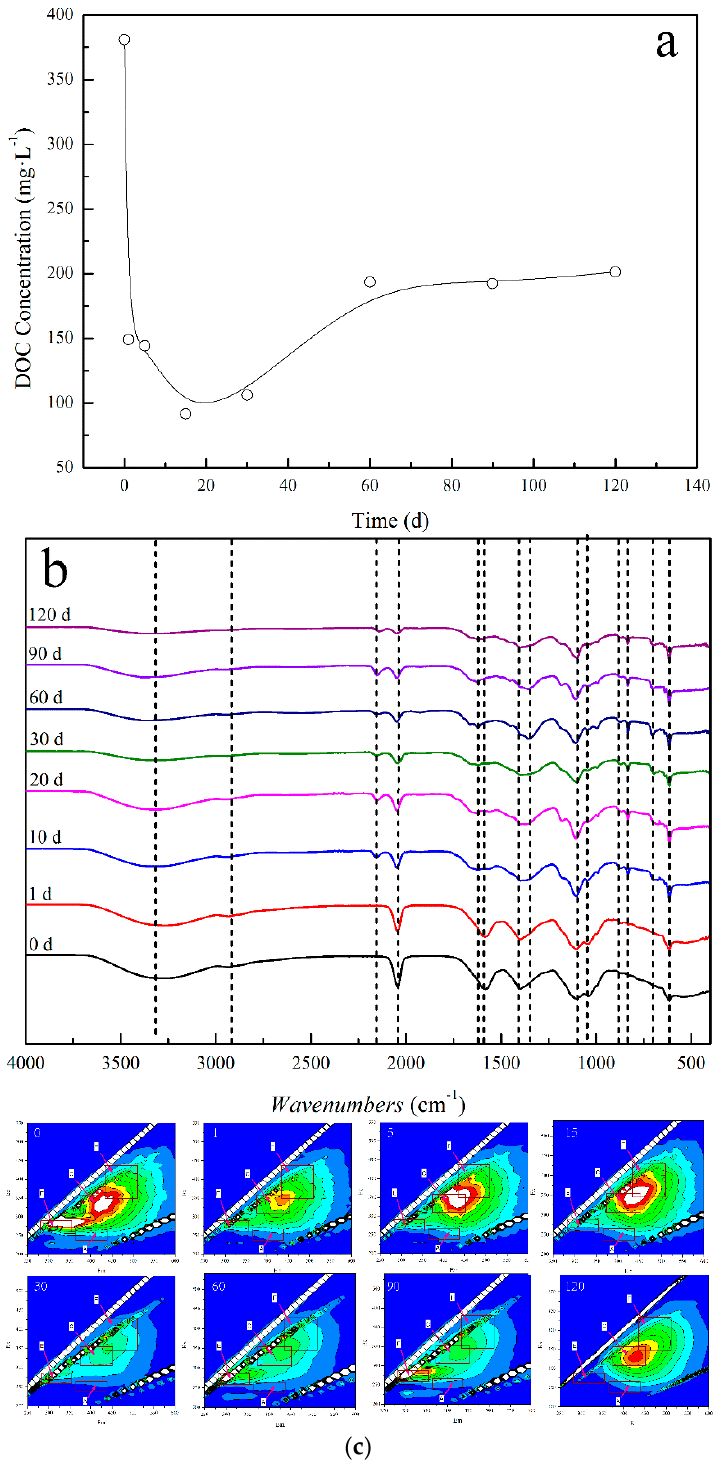
Figure 2. DOC concentration in DOM ( a ), FT-IR spectra of the DOM ( b ), and 3D-EEM spectra of DOM ( c ).